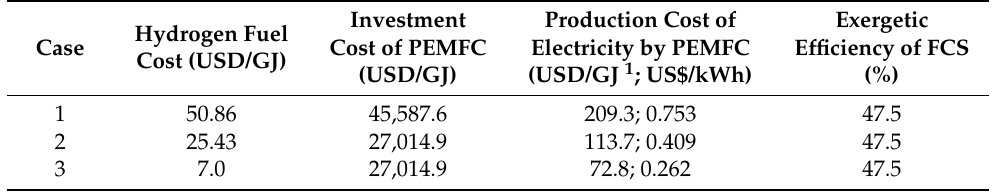
Table 5. Unit cost of electricity produced in hydrogen-fueled 5-kW PEMFC depending on hydrogen cost.